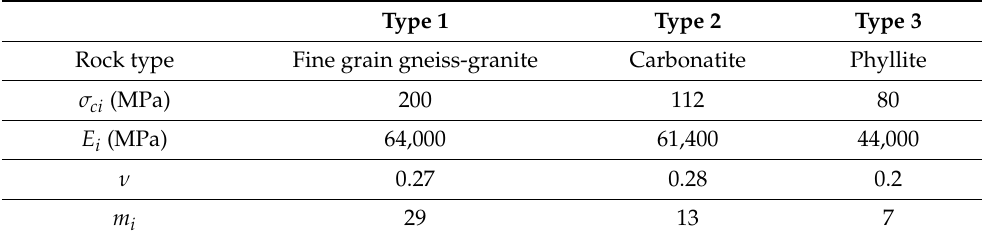
Table 2. Geological and mechanical properties for the three studied intact rocks.